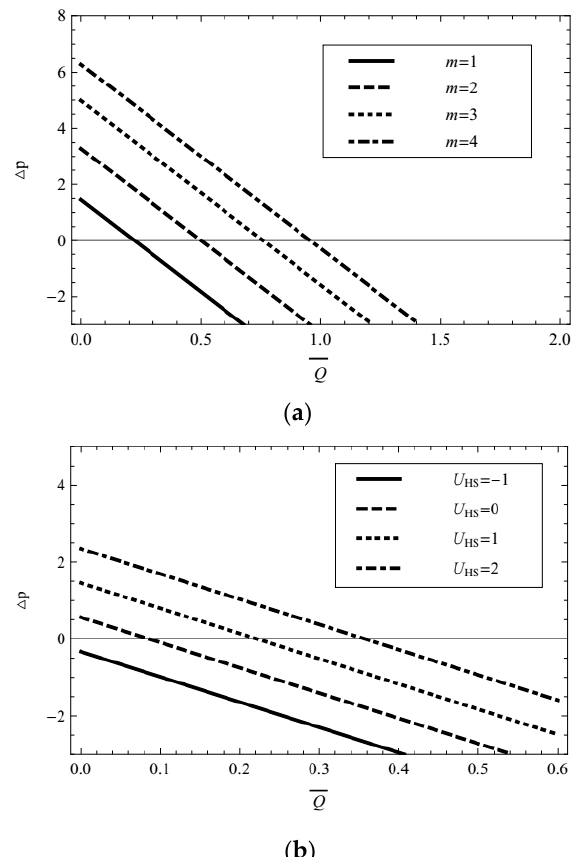
Figure 6. Profiles of the pressure gradient for fractional Jeffreys fluid (FJF) ( α = 0.4, β = 0.6, λ 1 = 1, λ 2 = 1), generalized second fluid (GSF) ( α = 0, β = 0.6, λ 1 → 0, λ 2 = 1), fractional Maxwell fluid (FMF) ( α = 0.4, β = 0, λ 1 = 1, λ 2 → 0), and Newtonian fluid (NF), with fixed m = 1, φ = 0.3, U HS = 1, Q = 0.1, t = 0.8.